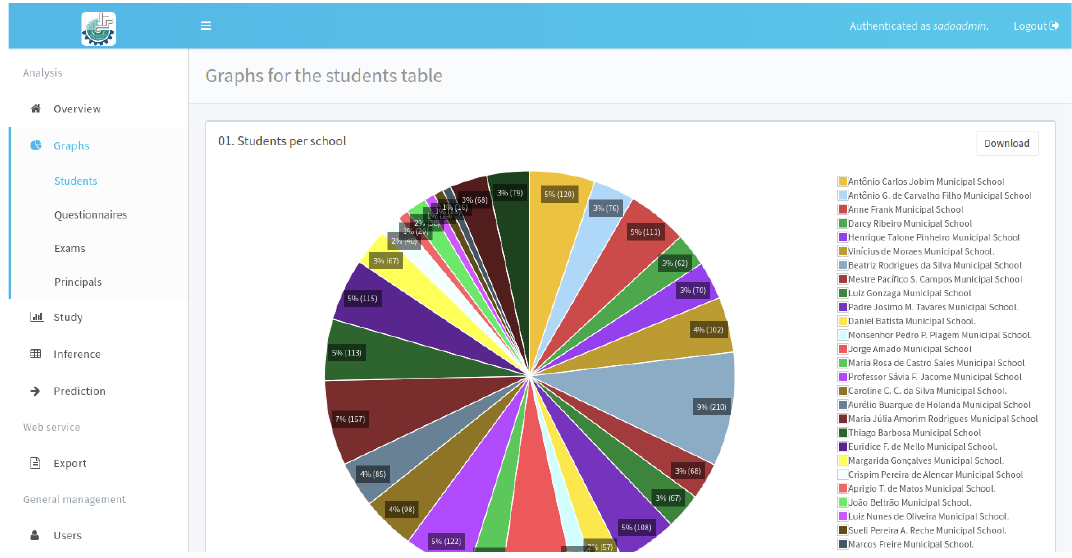
Figure 9. Desktop with overview of the web application. Source: Figure elaborated by the own author.